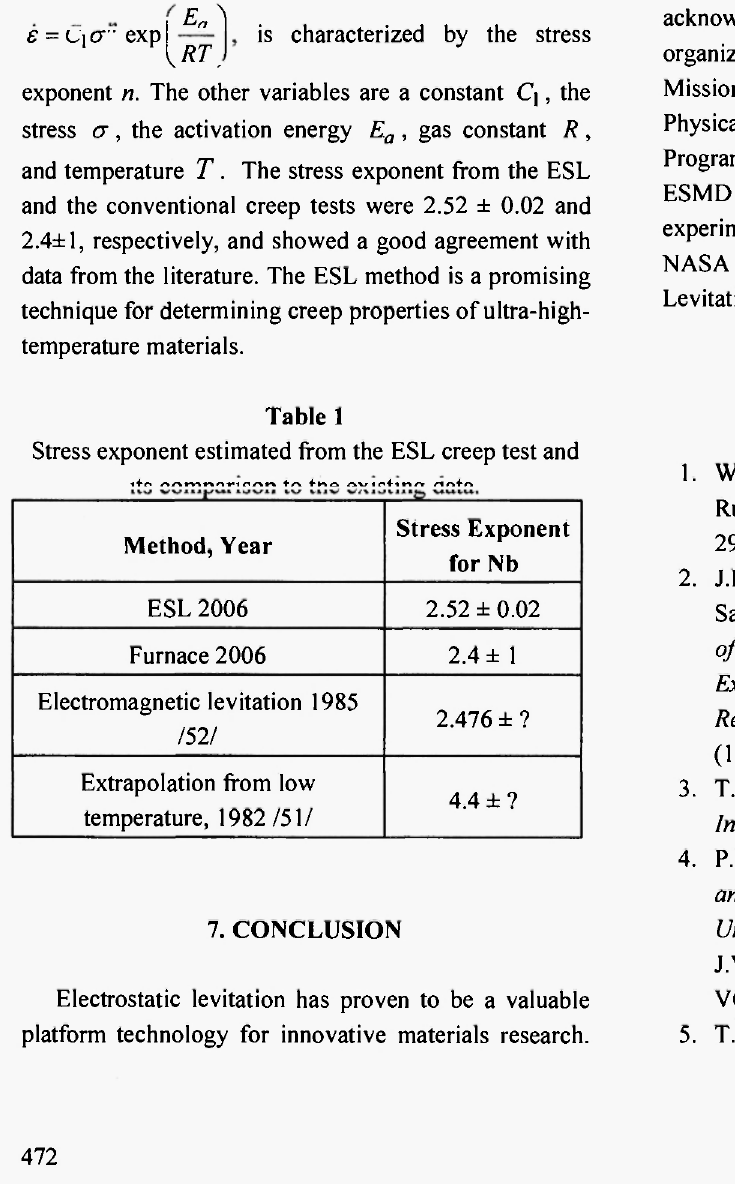
Stress exponent estimated from the ESL creep test